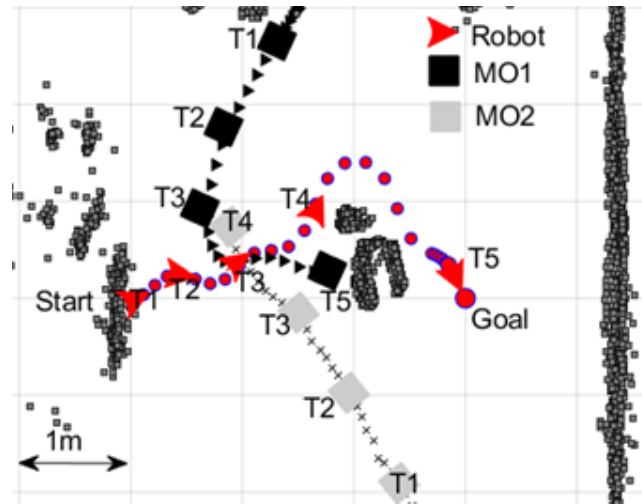
Figure 10. The robot’s observed path in Experiment 4. The locations of the robot and moving obstacles (MO1–MO2) are shown at five different time instants